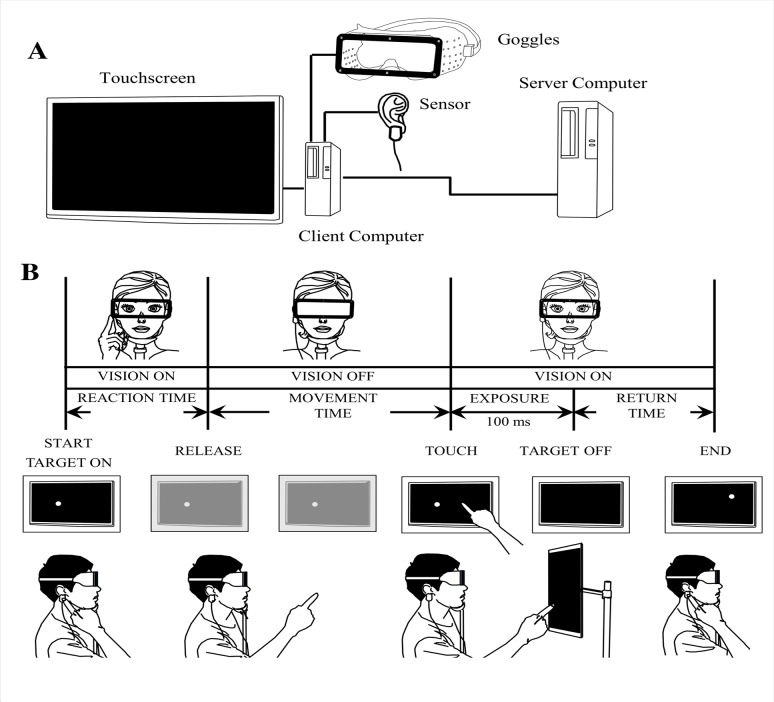
Scheme for prism adaptation of hand-reaching.(A) The experimental apparatus consists of a sensor on the participant’s right earlobe, goggles equipped with an electrically controlled shutter with a plastic or Fresnel prism plate, a touchscreen, and two computers. (B) Time sequence of a single trial shown from left to right. Every trial starts from the touch of a participant’s index finger at the sensor on the right earlobe. As soon as the participant releases their index finger from the sensor, vision is blocked by the shutter (MOVEMENT TIME). Immediately after reaching the touchscreen (TOUCH), the goggles become transparent, and the participant recognizes how their index finger deviated/hit the target for 100 ms (EXPOSURE). Subsequently, the target disappears (TARGET OFF) and the participant returns their index finger to the original position in preparation for the next trial.